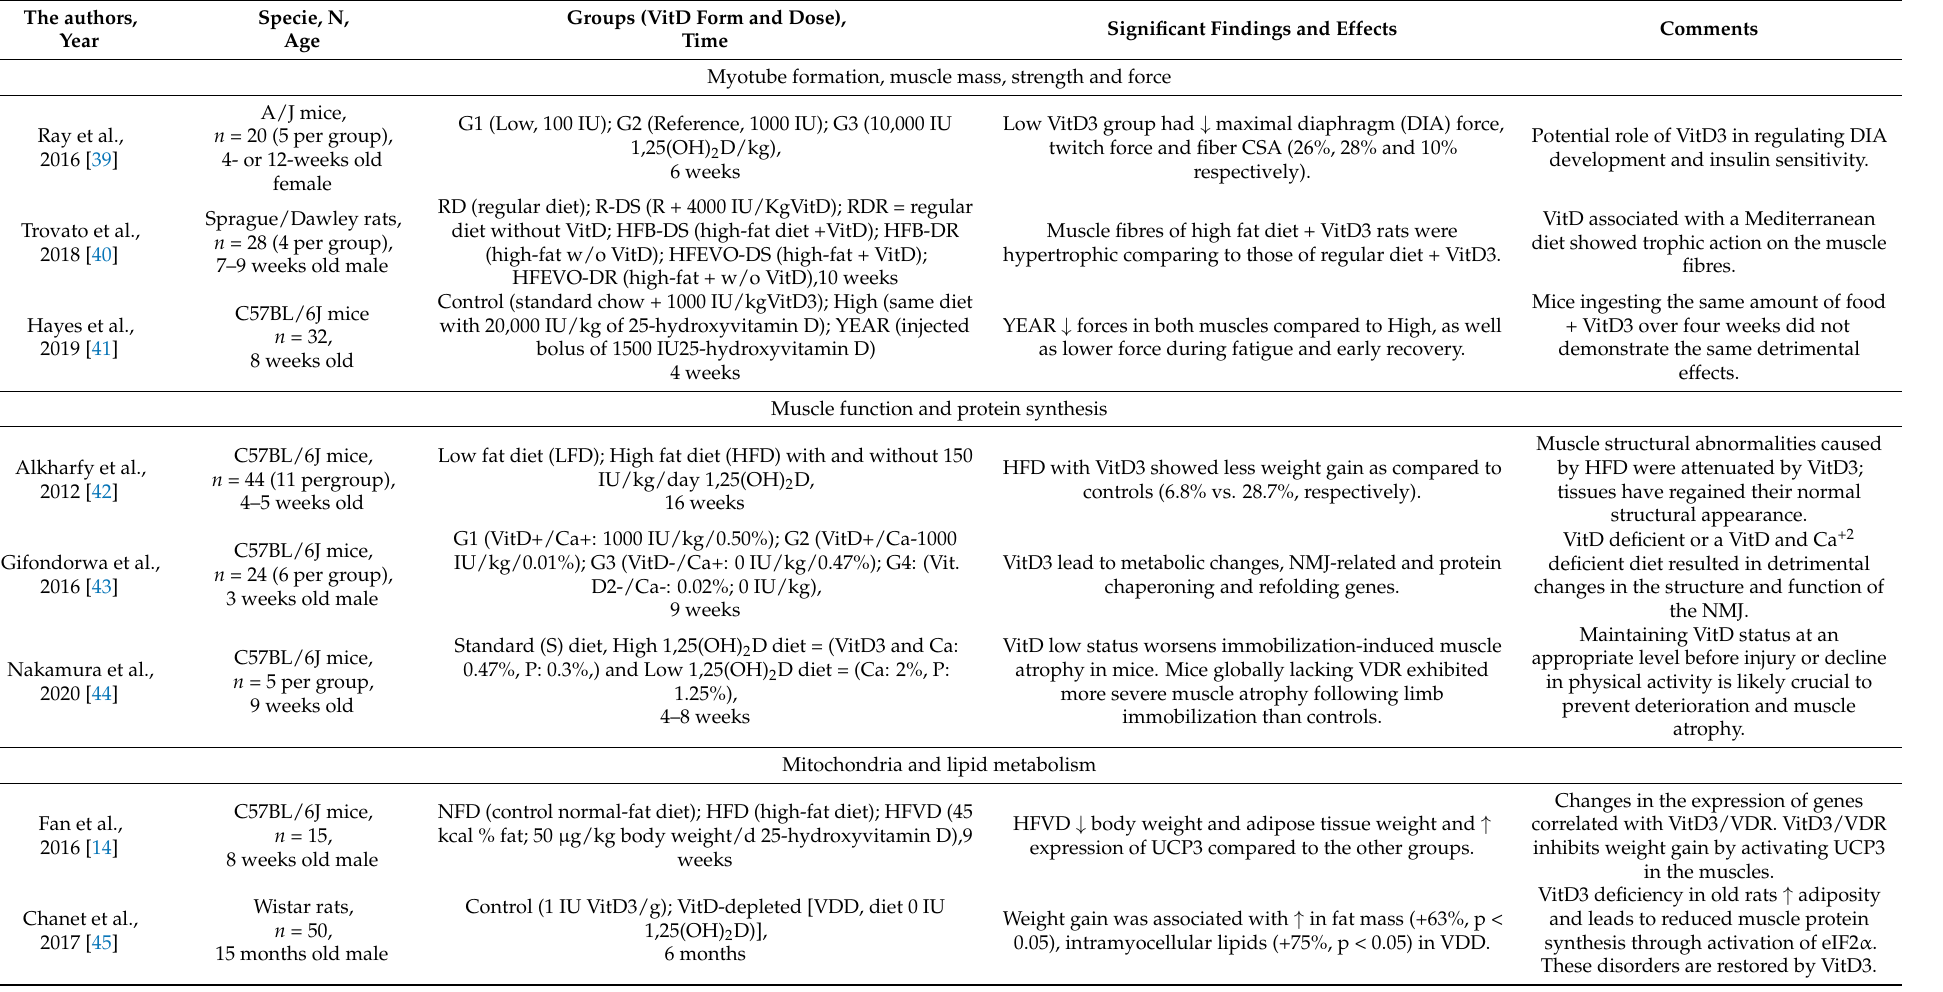
Table 2. Overview of the effects of vitamin D (VitD) in skeletal muscle ( n = 13 animal studies) stratified by